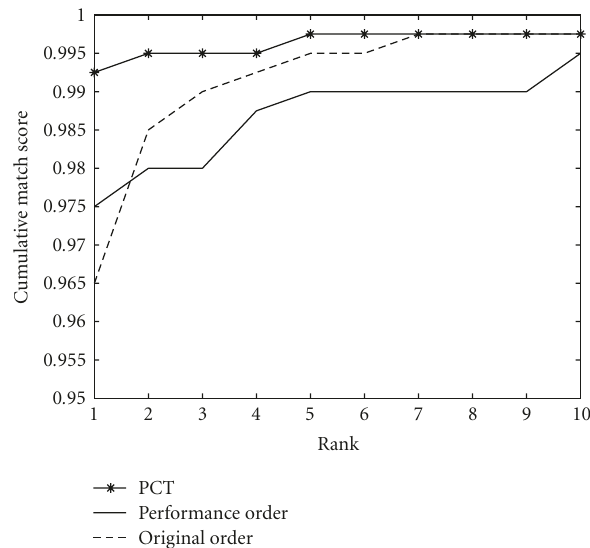
Figure 7: Cumulative match scores of multiband eigenface meth-